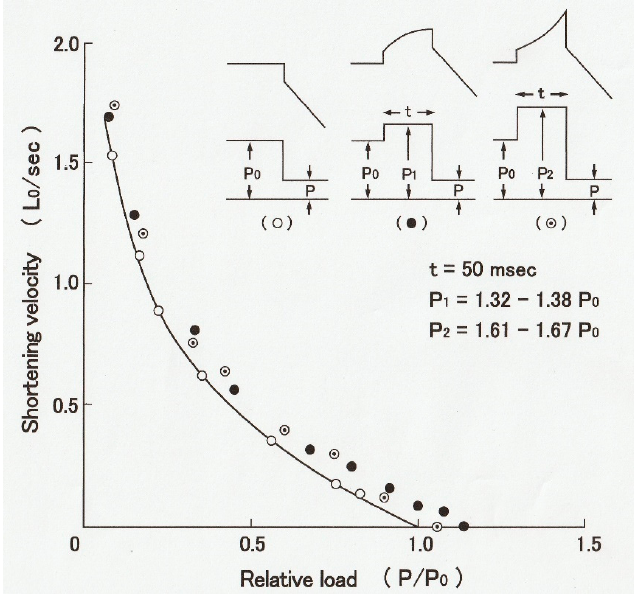
Figure 11. Shift of the P–V relation to the right along the force (load) axis as the result of enhancement of mechanical performance in isotonically lengthening muscle fibers. Open circles and the solid line show the P–V relation, obtained in the control condition, while filled and dotted circles show data points, obtained during isotonic lengthening under a load of 1.32~1.38 Po and 1.61~1.67 Po , respectively. Note that the shift of the P–V curve occurs at all levels of shortening velocity. From Ref. [15].